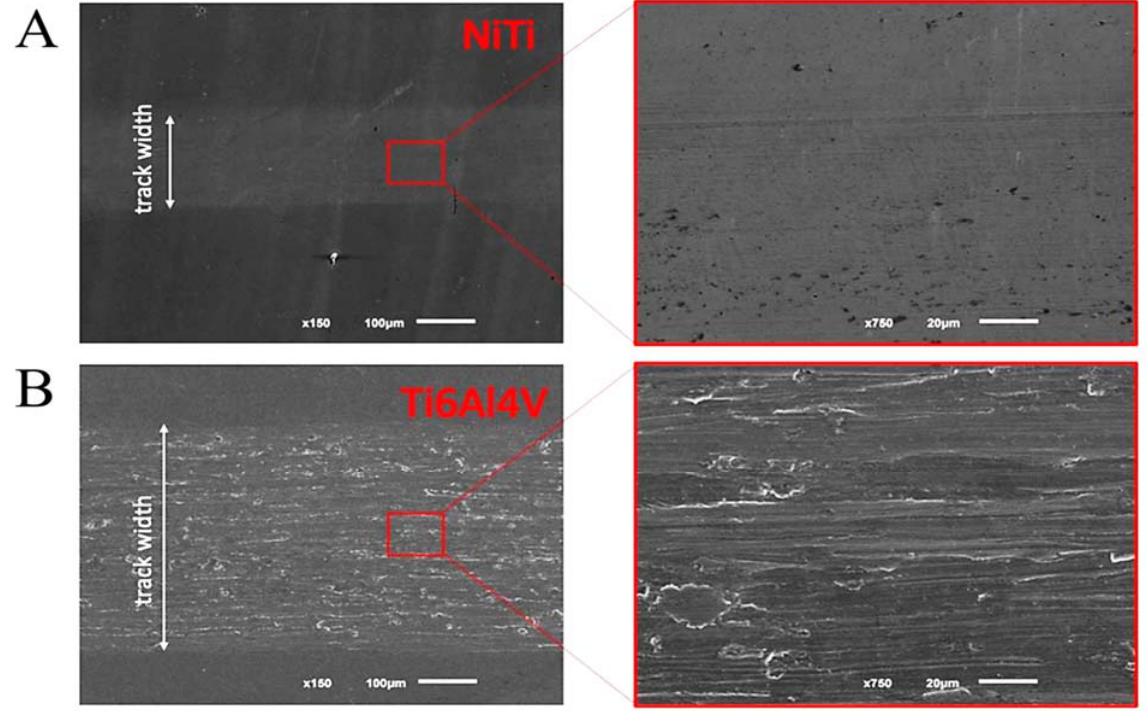
Figure 5. SEM images of wear tracks: ( A ) DED ‐ fabricated NiTi alloy and ( B ) DED ‐ fabricated Ti ‐ 6Al ‐ 4V alloy. Reproduced and adapted from [168] under Creative Commons Attribution 4.0 International License (CC BY 4.0).